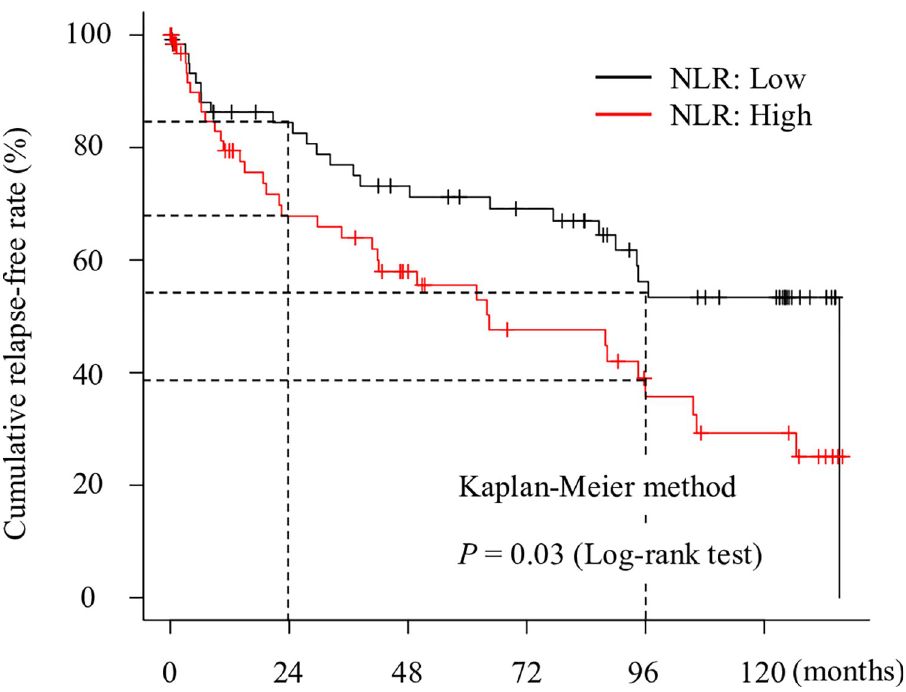
Fig 2. Comparison of cumulative incidence of clinical relapse between the high and low neutrophil-to-lymphocyte ratio (NLR) groups. The cumulative relapse-free rate in the high NLR group was 67.8% and 35.8%, and the cumulative relapse-free rate in the low NLR group was 84.4% and 53.4% at 24 and 96 months, respectively. The cumulative relapse-free rate was significantly higher in the low NLR group than in the high NLR group ( P = 0.03, log-rank test).